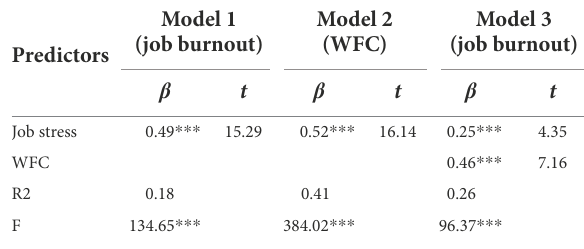
TABLE 2 Testing the mediation effect of job stress on burnout.